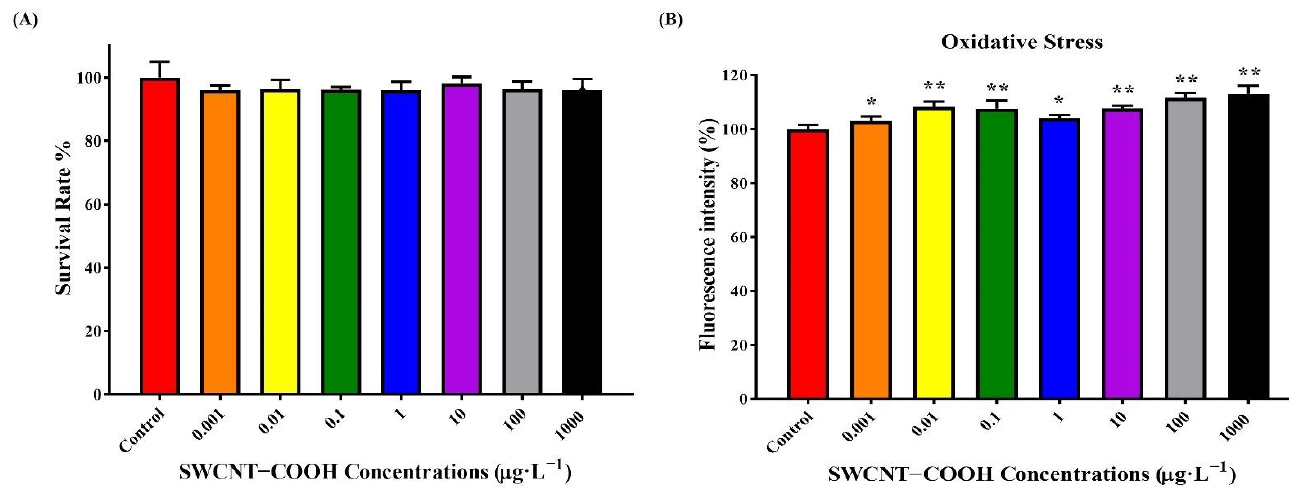
Figure 7. ( A ) Effects of SWCNTs − COOH on the viability of THP-1 cells after 48 h of exposure. ( B ) Effects of SWCNTs − COOH on ROS generation in THP-1 cells after 6 h of exposure. * p < 0.05; ** p < 0.01 as compared with the control.